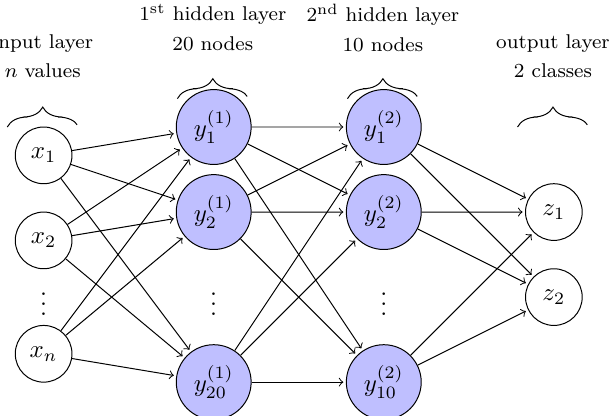
Figure 1: Multi Layer Perceptron with 2 hidden layers.